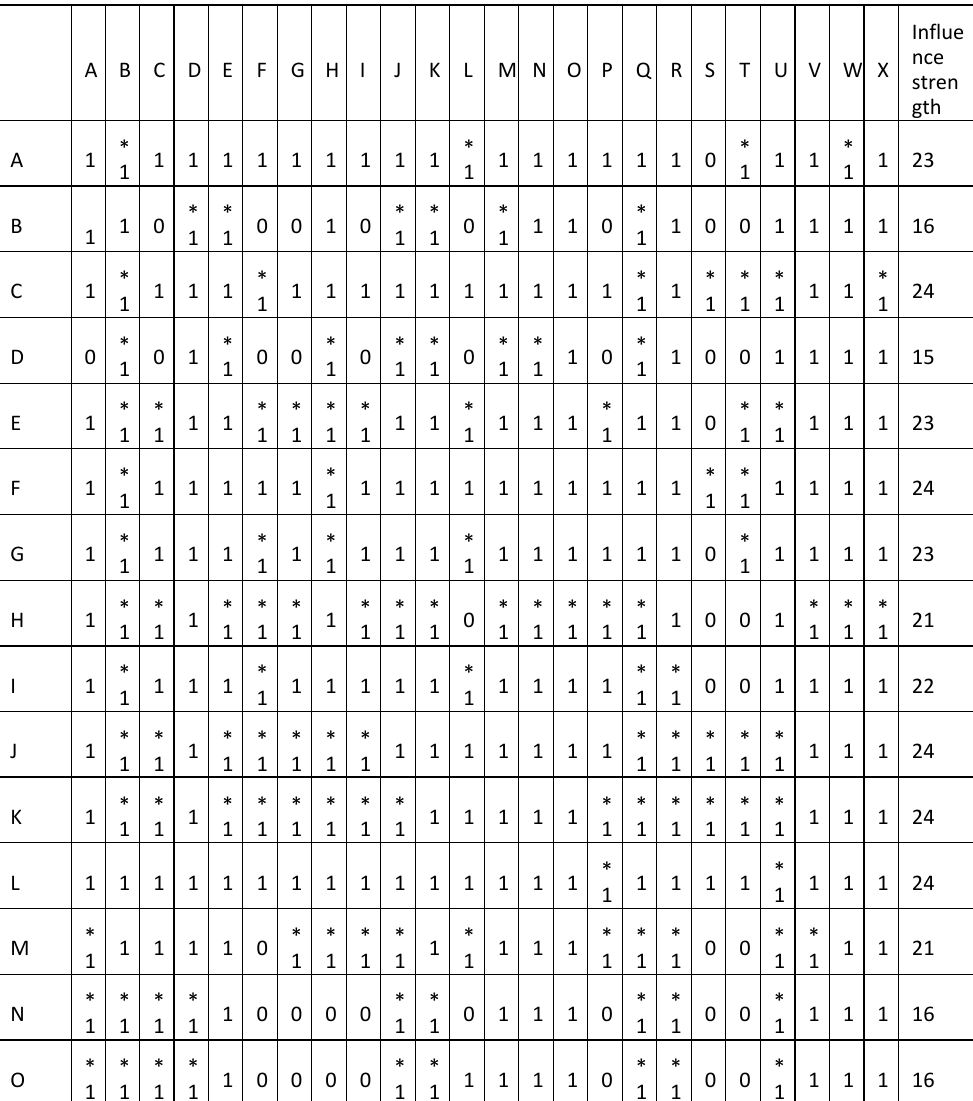
Table 3. The adapted initial access